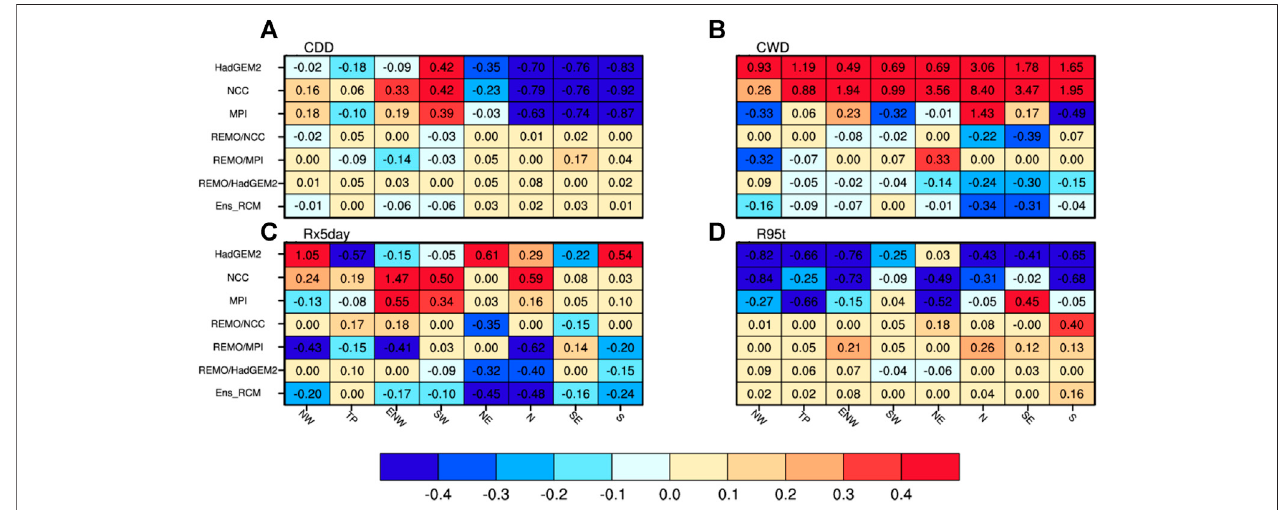
FIGURE 6| The RMSE ’ of the extreme indices for the three GCMs, the three RCM simulations and the RCM ensemble mean in the eight sub-regions. The number with blue color indicates a relatively better model result.